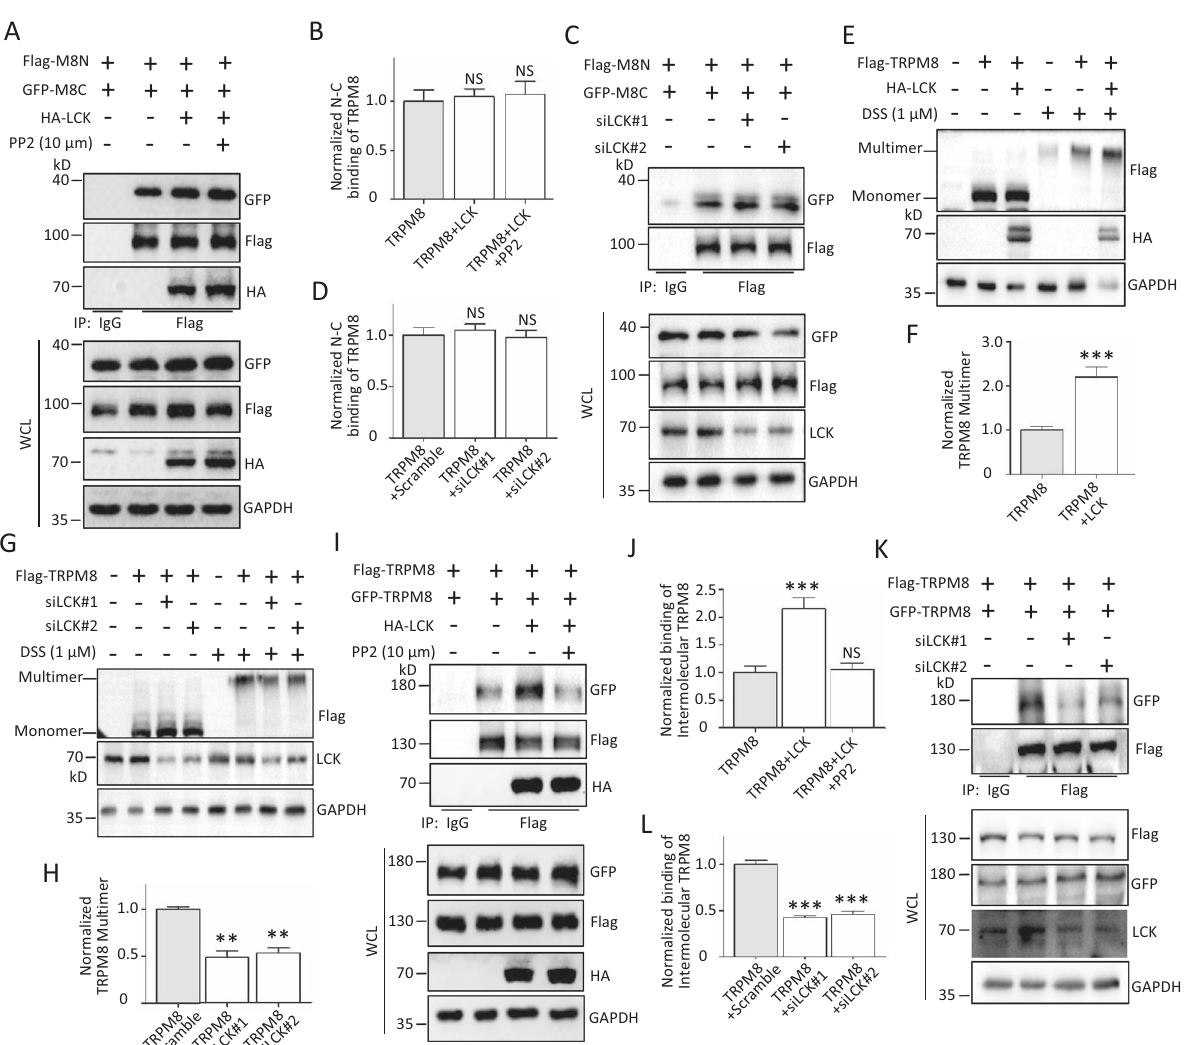
Fig. 3 The multimerization, but not intracellular N-C binding of TRPM8, regulated by LCK. A – D The effect of LCK on the intracellular N-C binding of TRPM8. A , B Expression constructs for Flag-tagged N-terminus of TRPM8 (Flag-M8N) and GFP-M8C were co-transfected with HA-LCK or control vector into HEK293T cells, before harvest for treatment with 10 μ M PP2 for 24 h. The cells were then harvested for IP with an anti- Flag antibody and WB assay with the indicated antibodies to determine the intracellular N-C binding of TRPM8. C , D Similar experiments in ( A ) and ( B ) but cells co-expressing Flag-M8N and GFP-M8C along with siLCK. E – L The effect of LCK on the multimerization of TRPM8. E , F Expression constructs for Flag-TRPM8 were co-transfected with HA-LCK or control vector into PANC-1 cells, before harvest for treatment with 1 μ M DSS for 30 min, a crosslinking agent. The cell lysates were subjected to WB assay with the indicated antibodies to detect the level of TRPM8 multimerization. G , H Similar experiments in ( E ) and ( F ) but cells co-expressing Flag-TRPM8 along with siLCK. I , J Flag-TRPM8 and GFP- TRPM8 were co-transfected with or without HA-LCK into AsPC-1 cells. The cells were then harvested for IP with an anti-Flag antibody and WB assay with the indicated antibodies to determine the binding of intermolecular TRPM8. K , L Similar experiments in ( I ) and ( J ) but cells co- expressing Flag-TRPM8 and GFP-TRPM8 along with siLCK. ** P < 0.01, *** P < 0.001, NS not signi fi cant. Data are presented as mean ± SEM. All studies were repeated at least three compared with WT-TRPM8 (Fig. 4G). At + 80 mV, mutant TRPM8- saracatinib (Fig. 4C, D), a potent and selective inhibitor of Src- Y1022F markedly decreased I TRPM8 densities to ~53% (Fig. 4H). In family tyrosine kinases (SRC, YES and LCK) [31]. An in vitro Kinase assay (Fig. 4E, F) further supported the conclusion that Y1022 in addition, mutant TRPM8-Y1022F did not affect the expression of TRPM8 is a potent phosphorylation target for LCK. Interestingly, total and PM TRPM8 with or without LCK (Fig. S3E – G). WB assays we found that mutant TRPM8-Y1022F signi fi cantly decreased showed that mutant TRPM8-Y1022F signi fi cantly reduced TRPM8 serine phosphorylation (phosphoserine) but did not alter threo- multimerization with or without LCK compared to WT-TRPM8 nine phosphorylation (phosphothreonine) of TRPM8 (Fig. S3A, B). (Fig. 4I, J). The mutant TRPM8-Y1022F signi fi cantly impaired the Moreover, LCK signi fi cantly enhanced TRPM8 phosphoserine and interaction of intermolecular TRPM8 (Fig. 4K, L), further supporting phosphotyrosine but not phosphothreonine (Fig. S3C, D). the importance of Y1022 for TRPM8 multimerization. Together, these We next recorded the cation currents mediated by mutant data suggested that mutant TRPM8-Y1022F modulated channel TRPM8-Y1022F in HEK293T cells and found that mutant TRPM8- function likely by modulating TRPM8 multimerization, con fi rming Y1022F decreased I TRPM8 densities across at depolarization when the effects of LCK on TRPM8 function and multimerization.